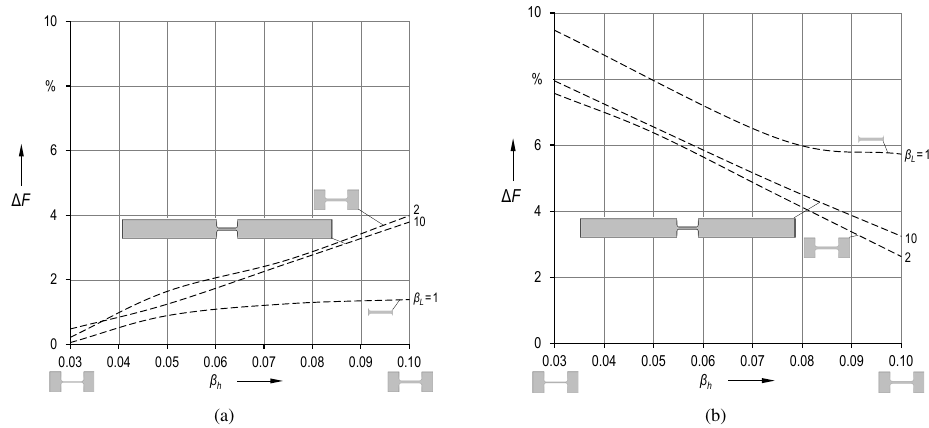
Figure 12. Parameter study of a corner-filleted flexure hinge with β l = 1 under the parameter variations β L = { 1 , 2 , 10 and β h = [ 0 . 03 , 0 . 1 ] showing the force deviation (cid:49)F of the FEM results compared to the design tool results computed for an angle input of | ϕ | = 10 ◦ : (a) β w = 0 . 1, (b) β w =